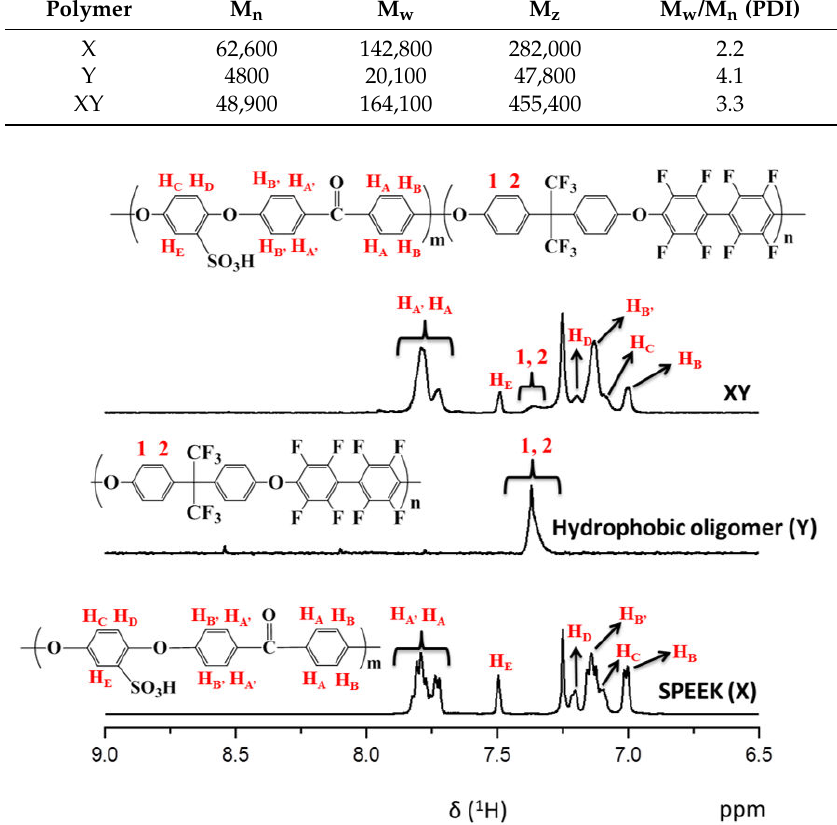
Figure 2. Proton nuclear magnetic resonance ( 1 H NMR) spectra of X, Y, and XY block copolymers. SPEEK—sulfonated poly(ether ether ketone).